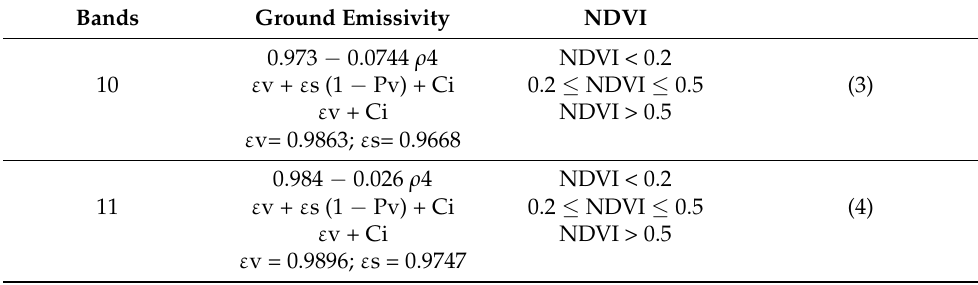
Table 3. Estimation of ground emissivity normalized vegetation index (NDVI THM ). Bands Ground